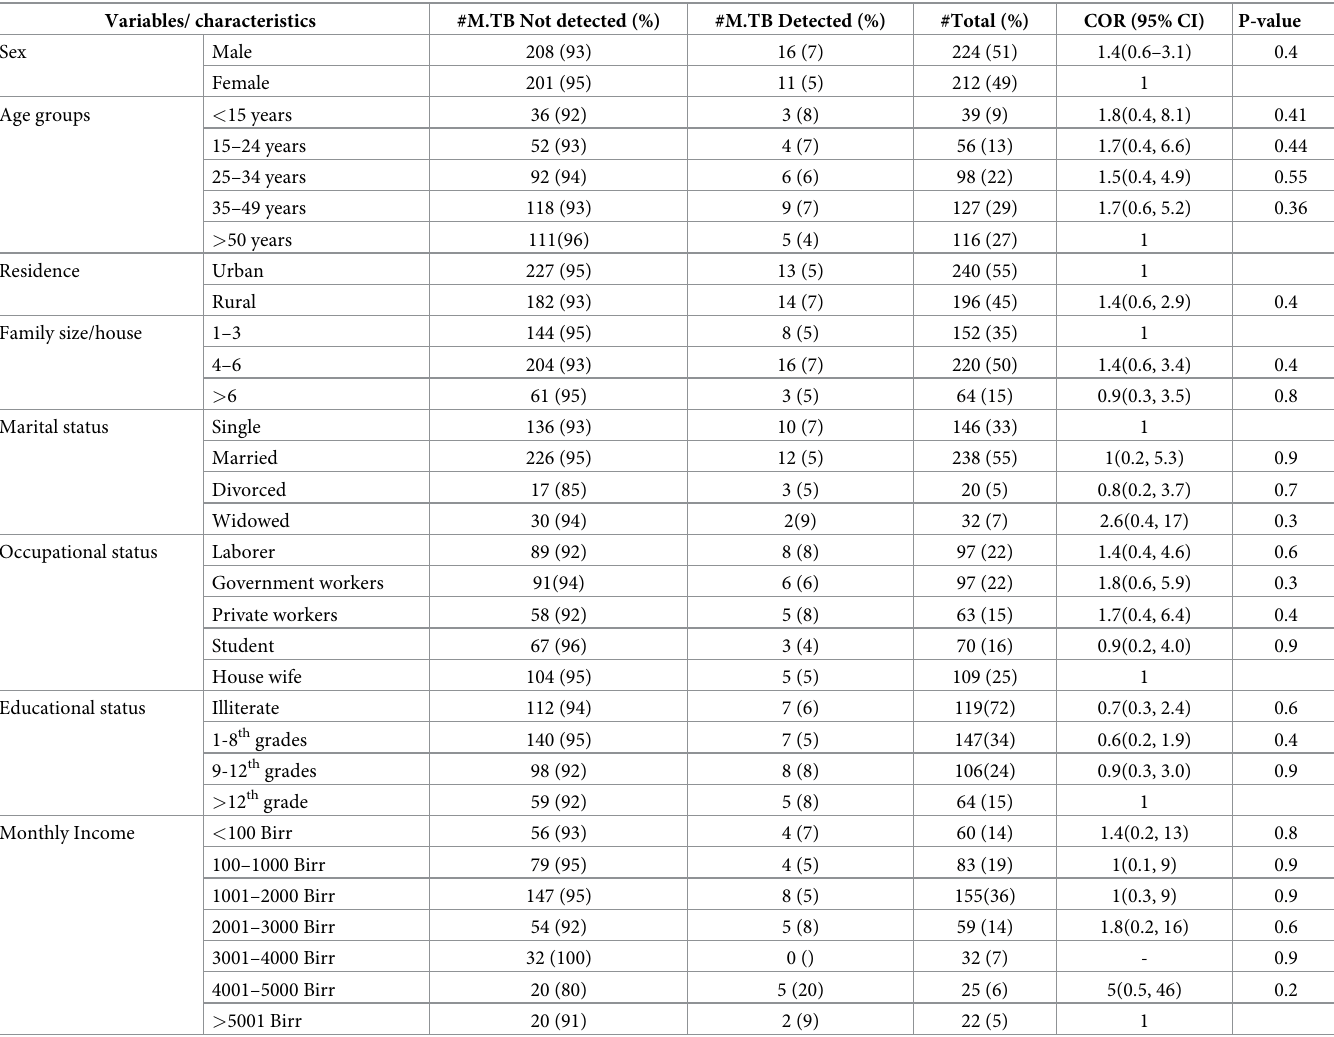
Table 3. Socio-demographic factor analysis of M . Tuberculosis among presumptive TB patients at SPHMMC, Addis Ababa, Ethiopia, 2019. Variables/